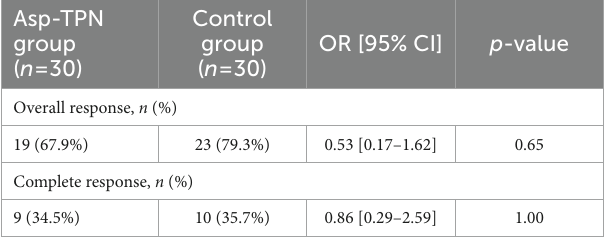
TABLE 2 Response rates according to the concomitant use of total parenteral nutrition containing L-aspartic acid. Asp-TPN group